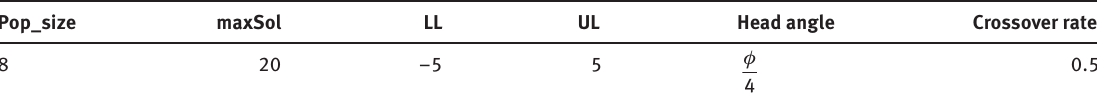
Table 12: Parameters of GGSO